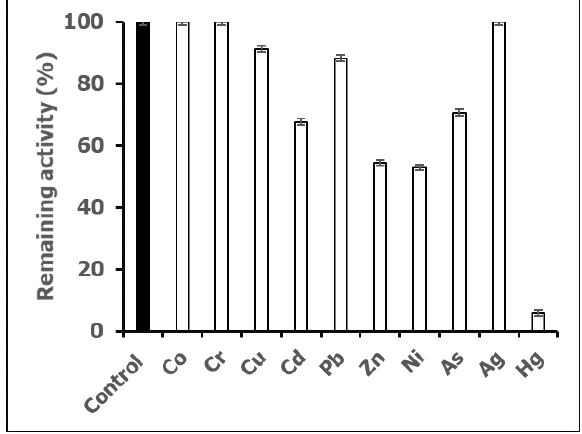
Fig. 5. Heavy metals bioassay of 10 mg/L concentration on AChE activity from Diodon hystrix brain. Data repre- sented in mean of triplicates ± standard deviation.